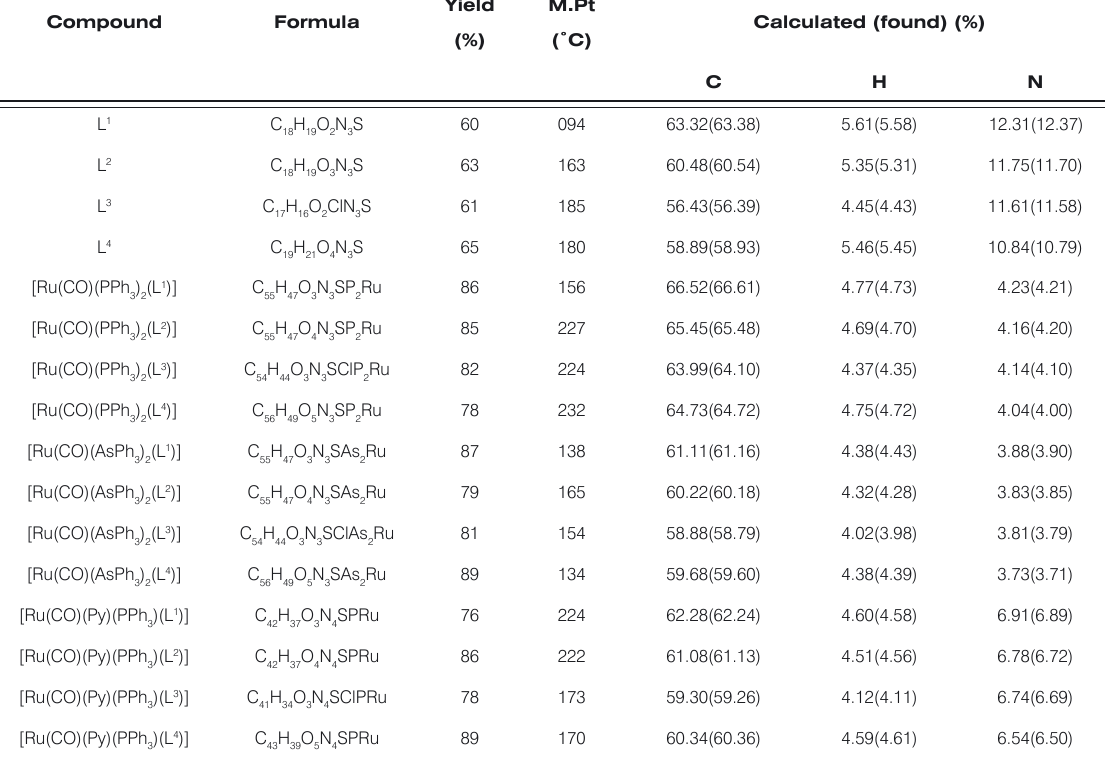
Table 1. Analytical data of free ligands and their ruthenium(II) chalcone thiosemicarbazone